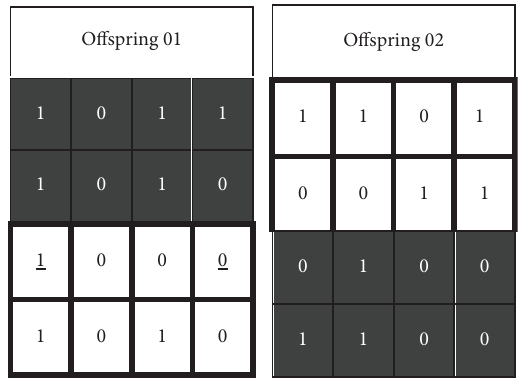
Figure 4: Two ofspring produced after